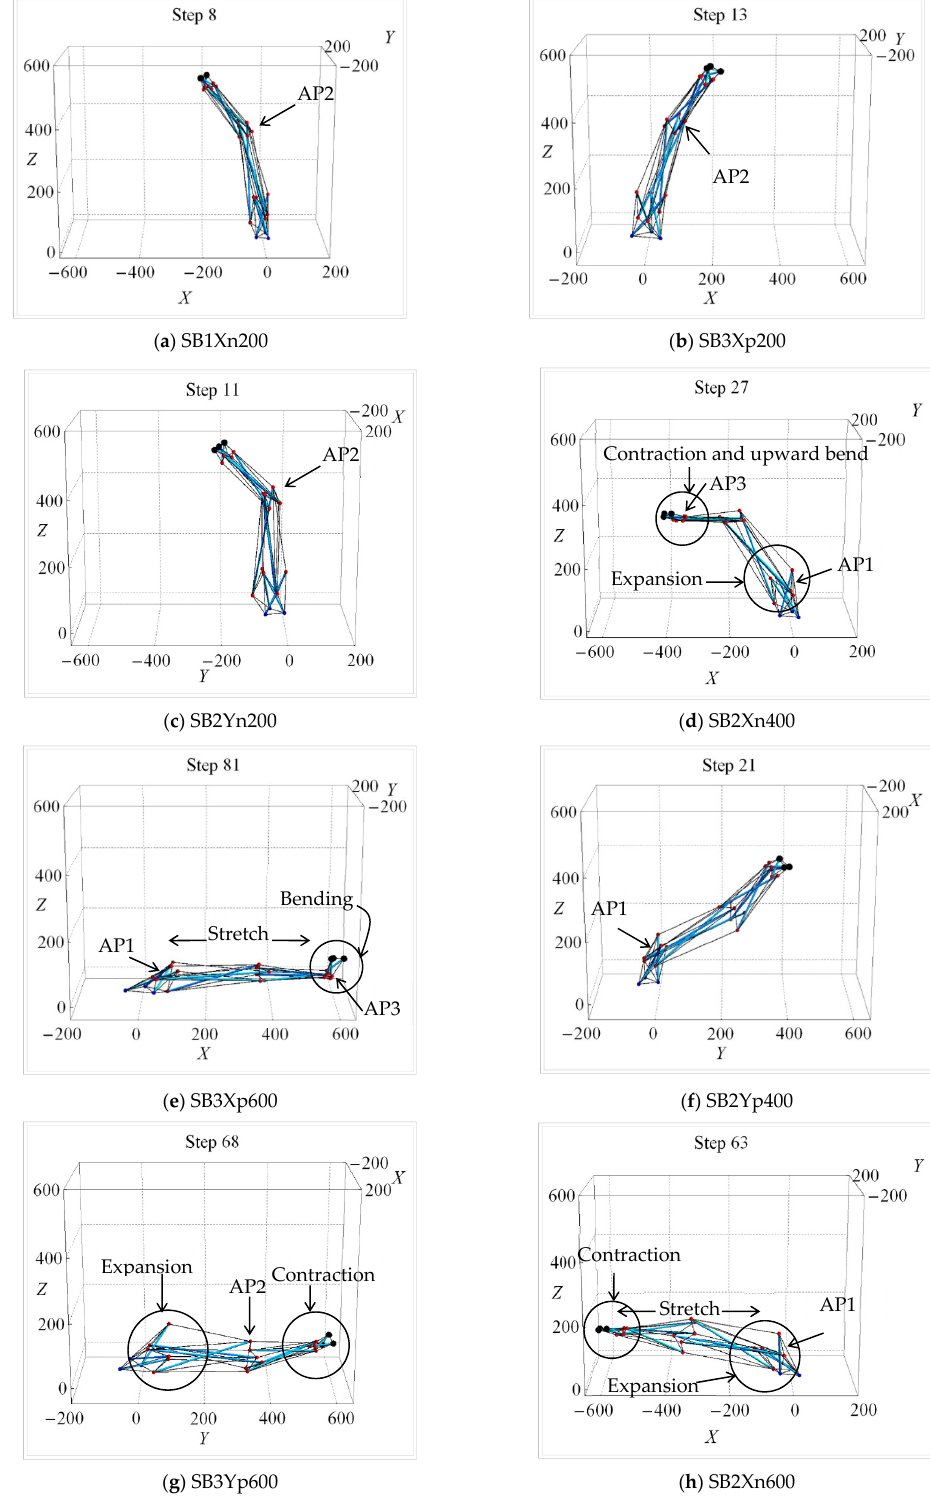
Figure 15. Deformed configuration ( a – h ) at the final step for cases with the uni-directional mode, series Xn, Xp, Yn and Yp.